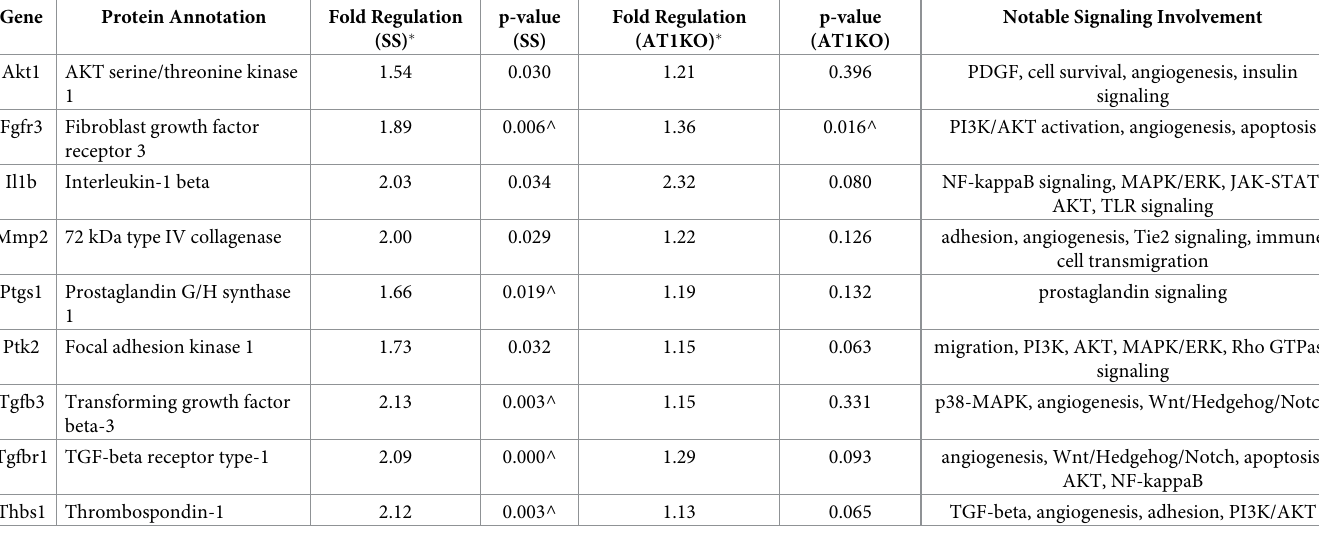
Table 1. Analysis of an angiogenesis RT-PCR gene expression array following Ang-(1–7) stimulation of rat microvascular endothelial cells. Gene Protein Annotation Fold Regulation